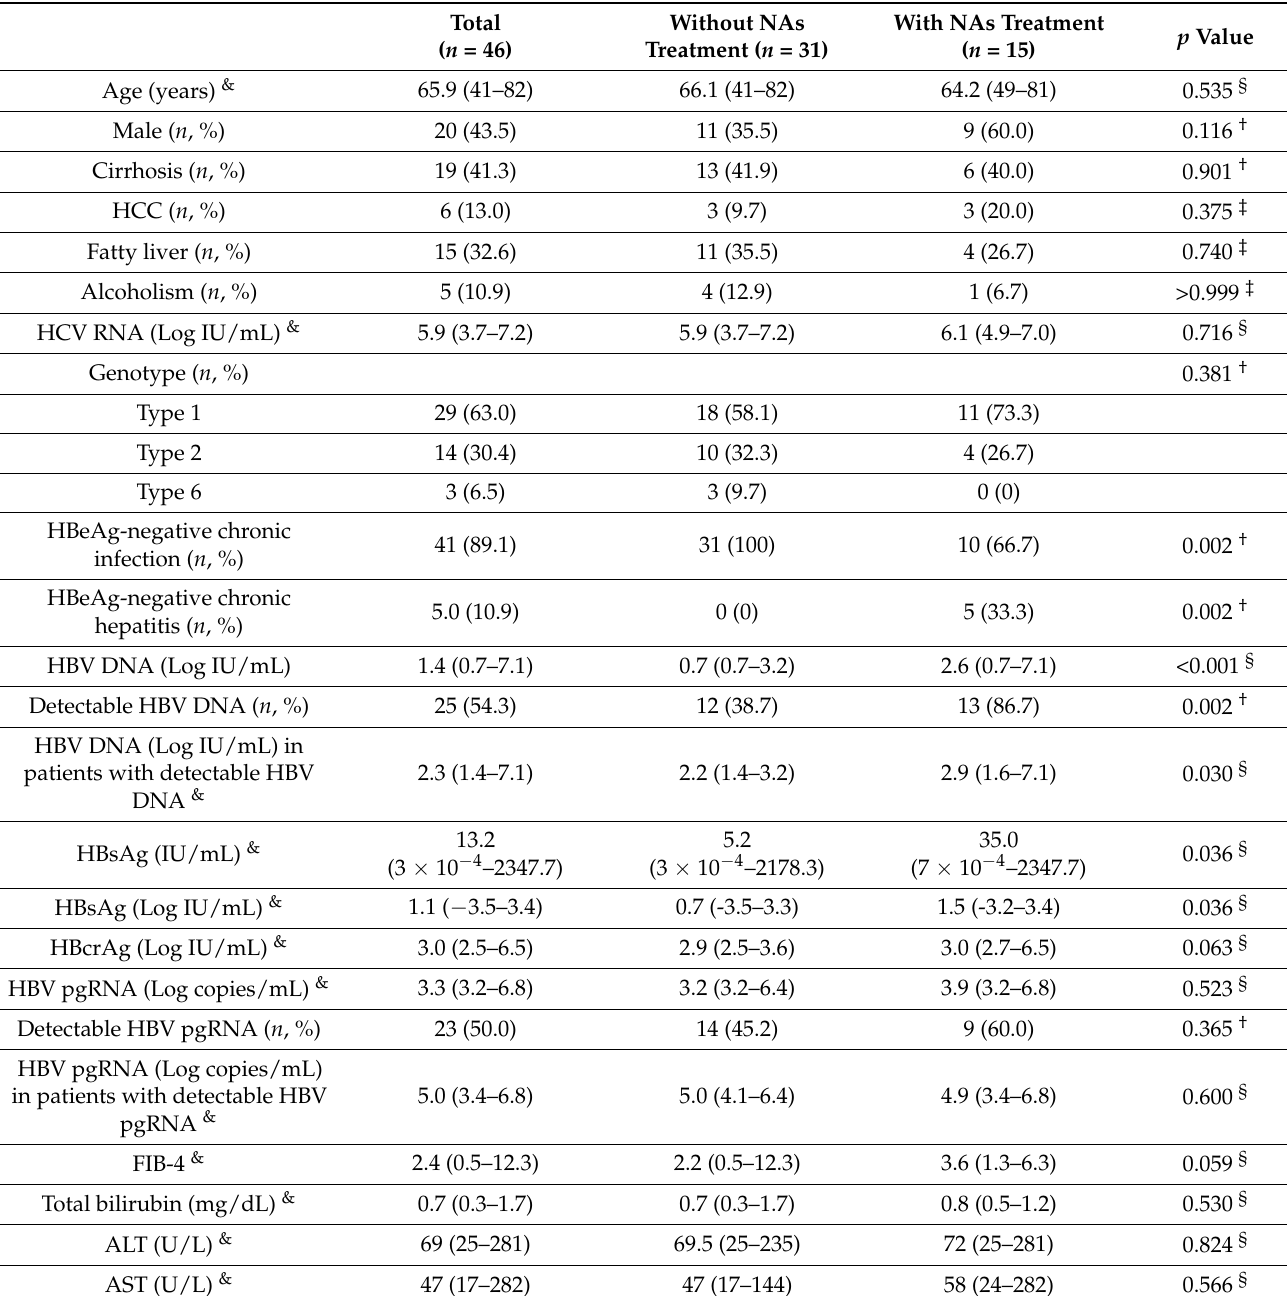
Table 1. Baseline clinical and virological characteristics of the HBV/HCV coinfected patients receiving DAA therapy ( n =